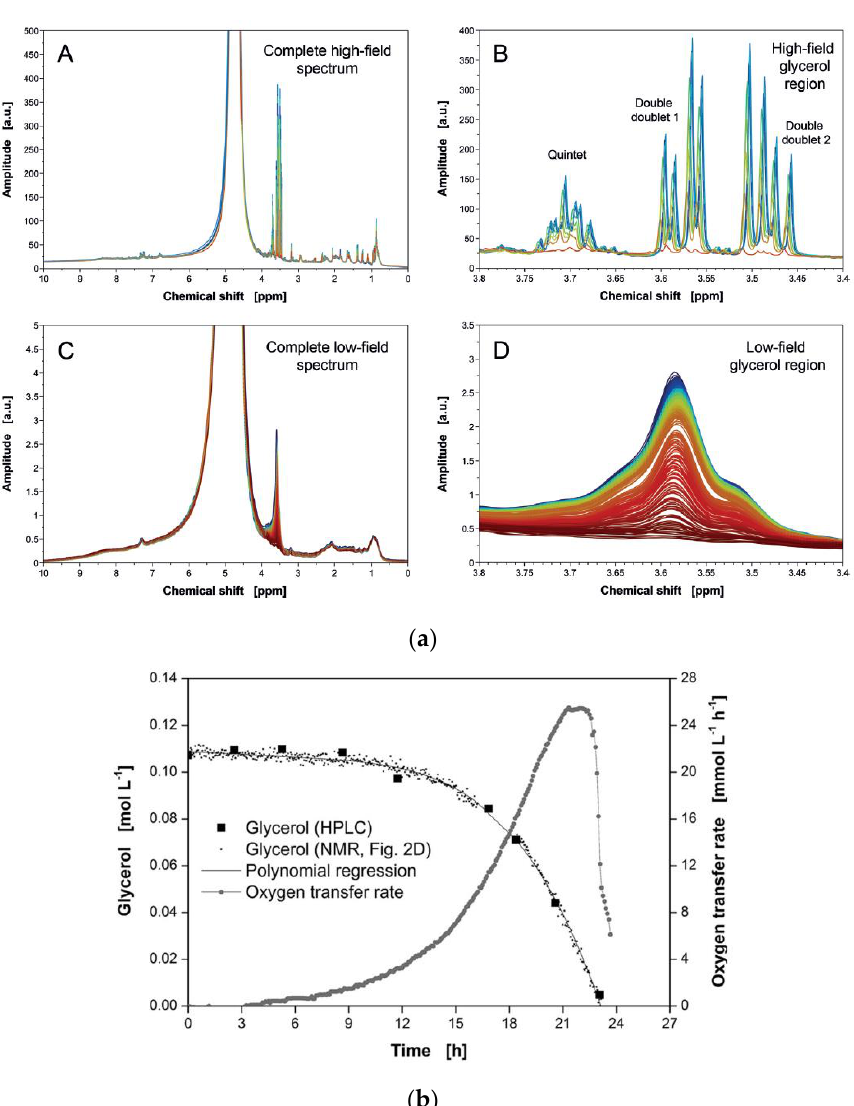
Figure 8. ( a ) Comparison of high-field NMR ( A , B ) and low-field NMR ( C , D ) spectra used to monitor yeast-induced fermentation. The former spectra were obtained offline at 400 MHz, while the latter were obtained online at 43 MHz. ( b ) Online monitoring of glycerol consumption using benchtop NMR spectroscopy and comparison of the results with those obtained using high-performance liquid chromatography. Adapted with permission from [89], Wiley, 2015.